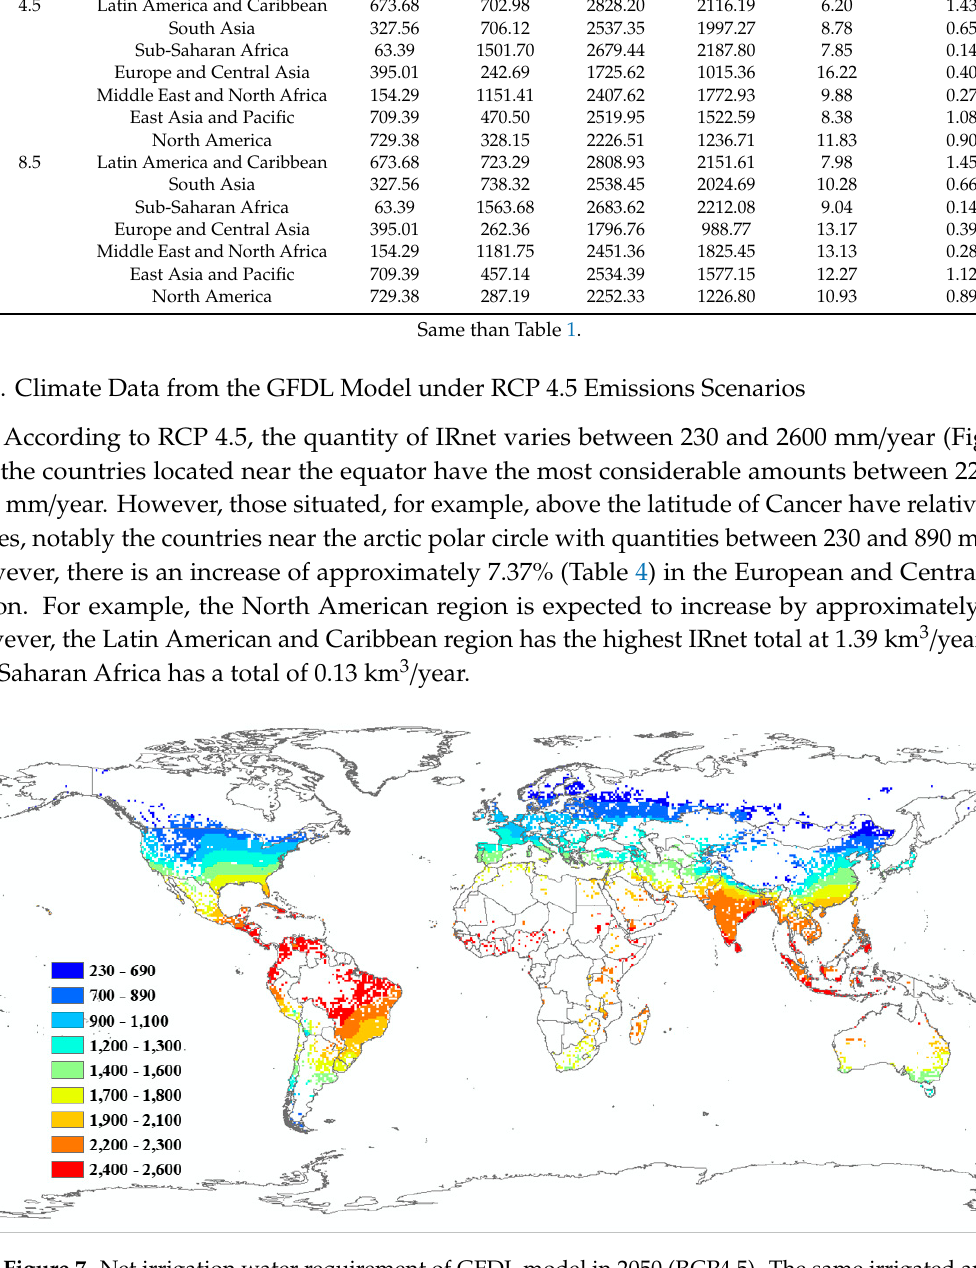
Figure 7. Net irrigation water requirement of GFDL model in 2050 (RCP4.5). The same irrigated area than in 1960 is used the same in figure 1. Table 4. GFDL regional net irrigation water requirement.